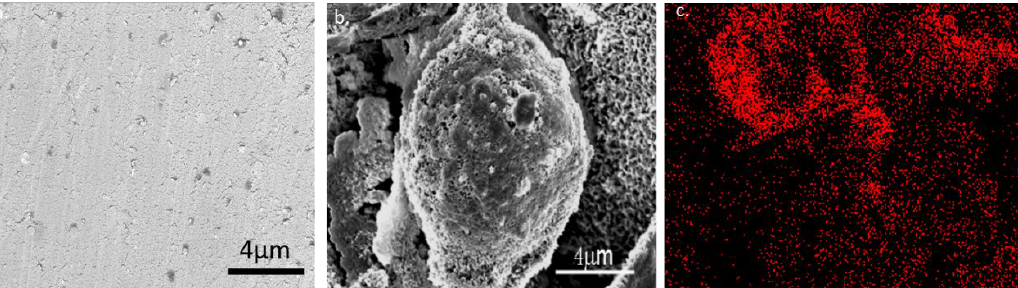
Figure 1. High-resolution scanning electron microscopy images of L-CIL(Pro)-C on nickel foil obtained by HR-SEM and EDAX. ( a ) pure Ni foil surface ( b ) carbonized Ni foil ( c ) EDAX mapping of carbon on the Ni surface of carbonized Ni foil.